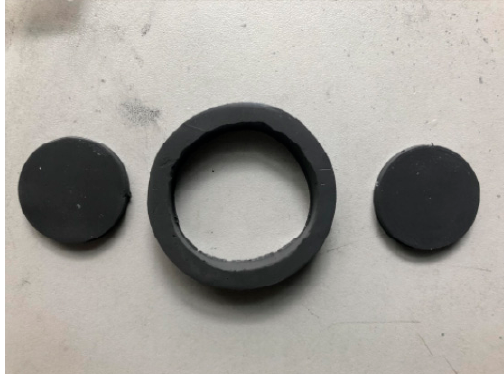
Figure 6. Physical view of the MRE.